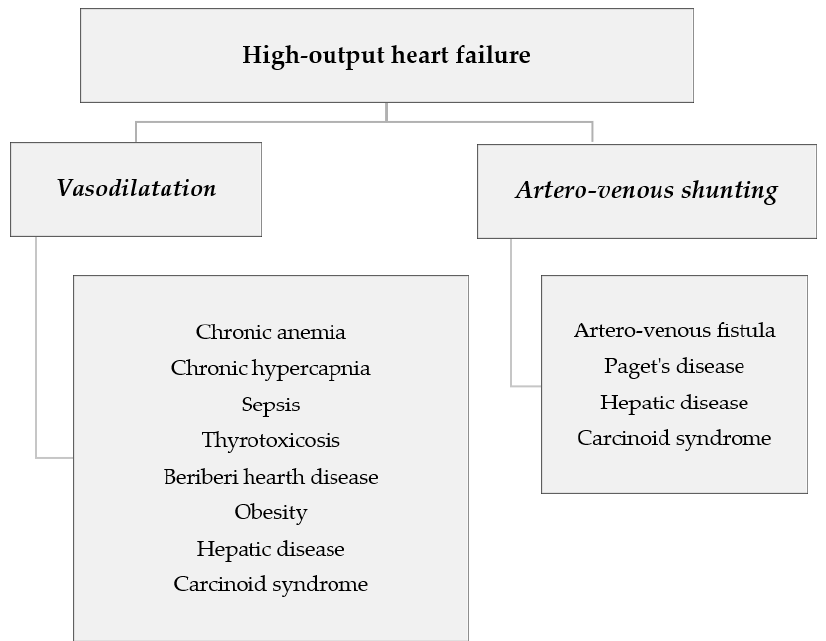
Figure 1. Pathogenetic mechanisms and common causes of high-output heart failure.